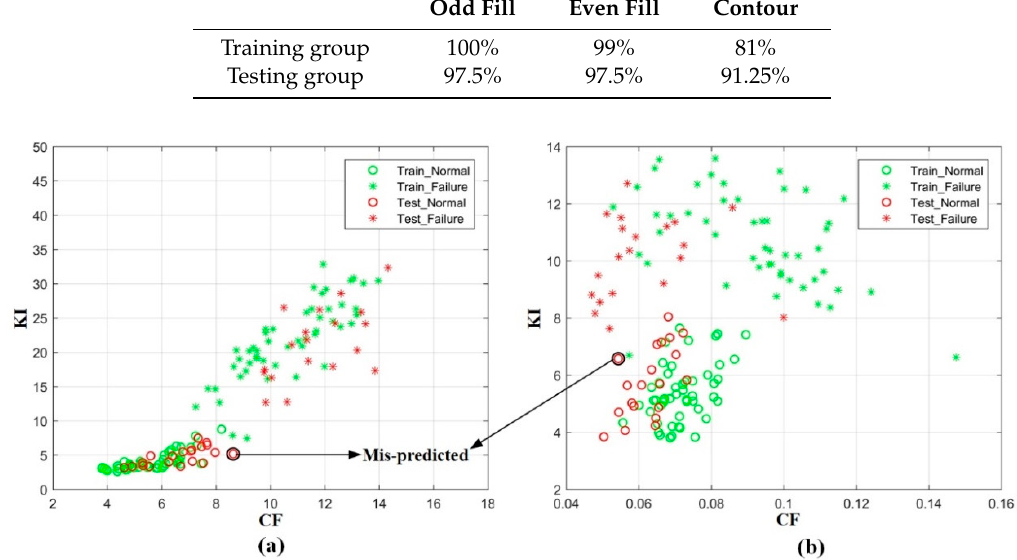
Figure 7. The results predicted using the multi-features based on the LS-SVM: ( a ) the 45-degree filling; ( b ) the 135-degree filling.